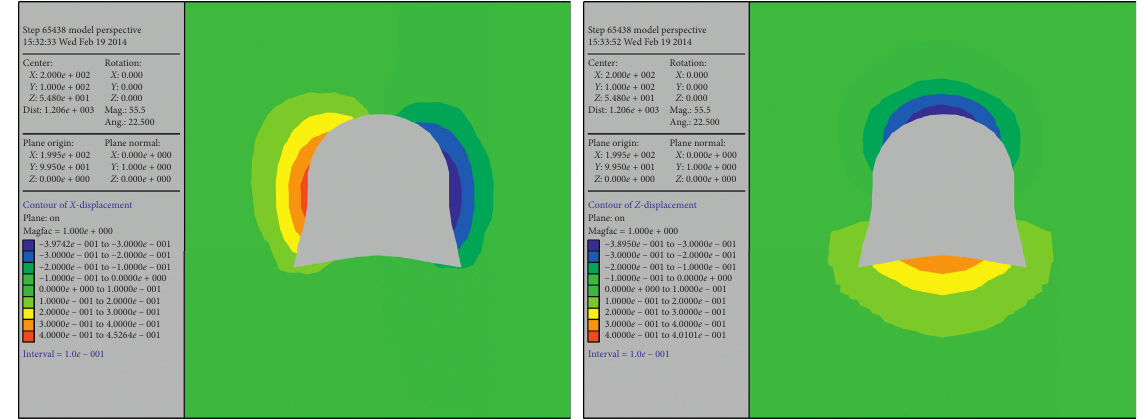
Figure 11: The nephograms of displacement (Scheme 1).